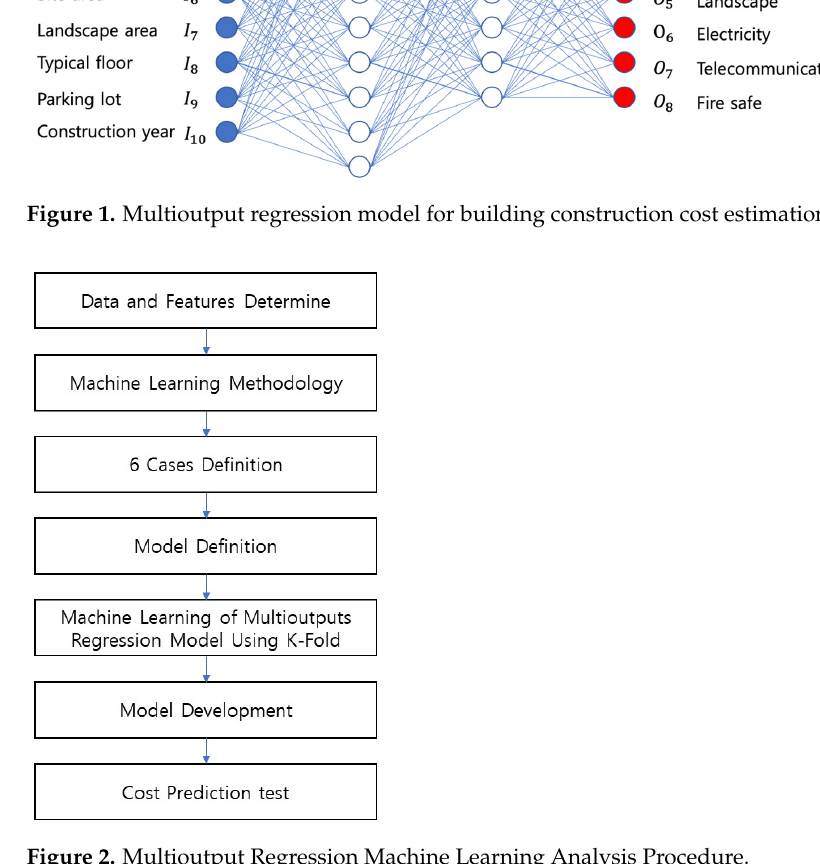
Figure 1. Multioutput regression model for building construction cost estimation.